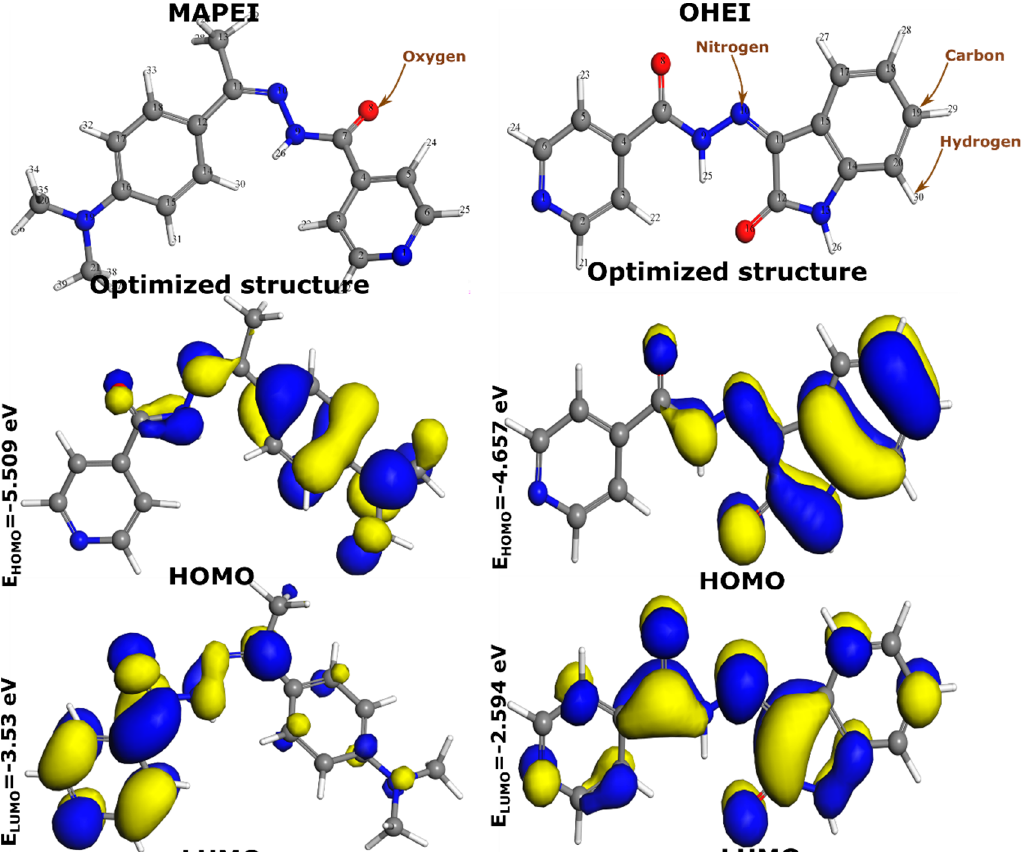
Figure 6. Optimized structures of MAPEI and OHEI molecules and their HOMO and LUMO iso- surfaces obtained at DFT-GGA-DNP level in the aqueous phase.